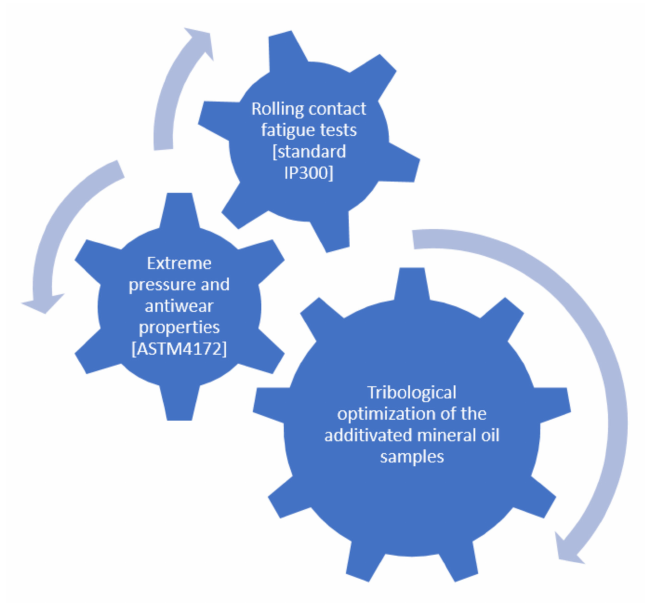
Figure 2. Research development